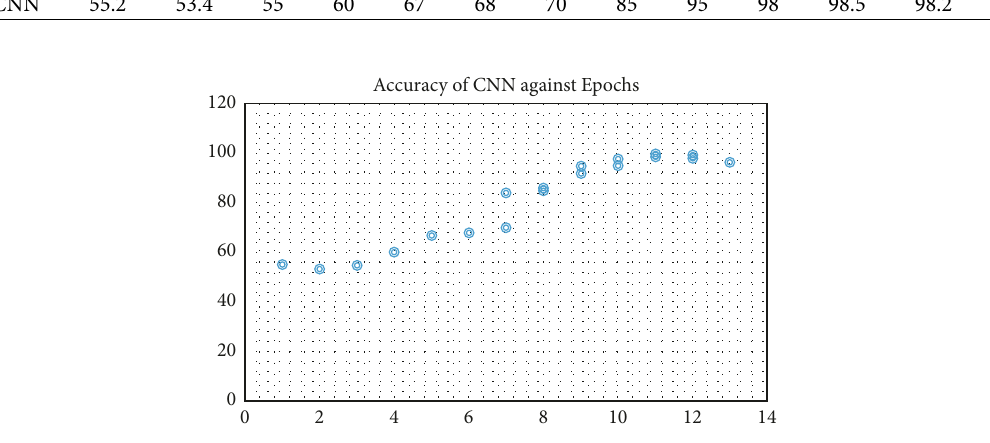
Figure 8: Accuracy of CNN increases with the number of epochs.